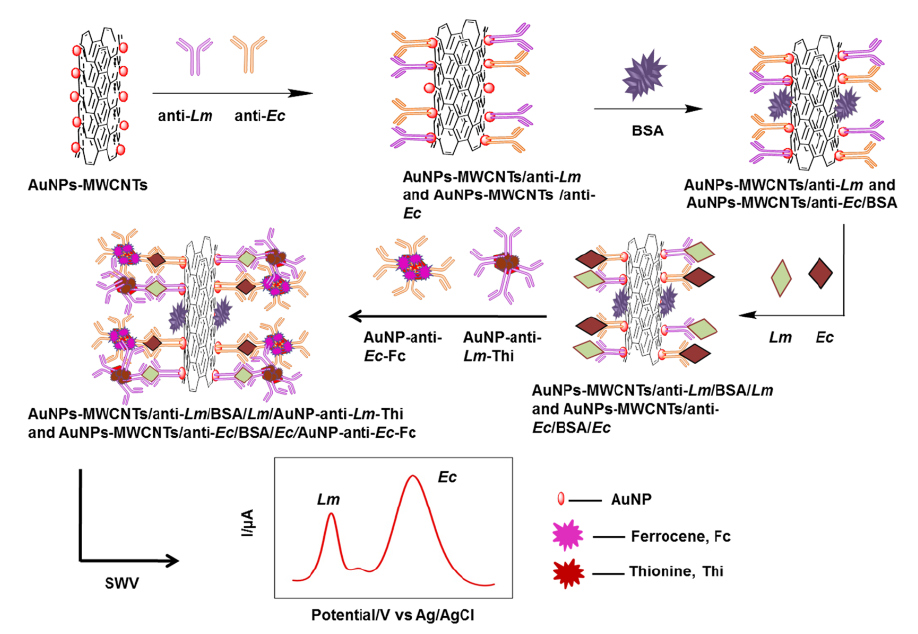
Figure 5. An example of a biosensor that used Au nanomaterials composed of multi-walled carbon nanotubes to increase detection sensitivity [113]. Table 5. Some of the nanoparticles that were used for the development of L.M.-detecting biosen- sors.